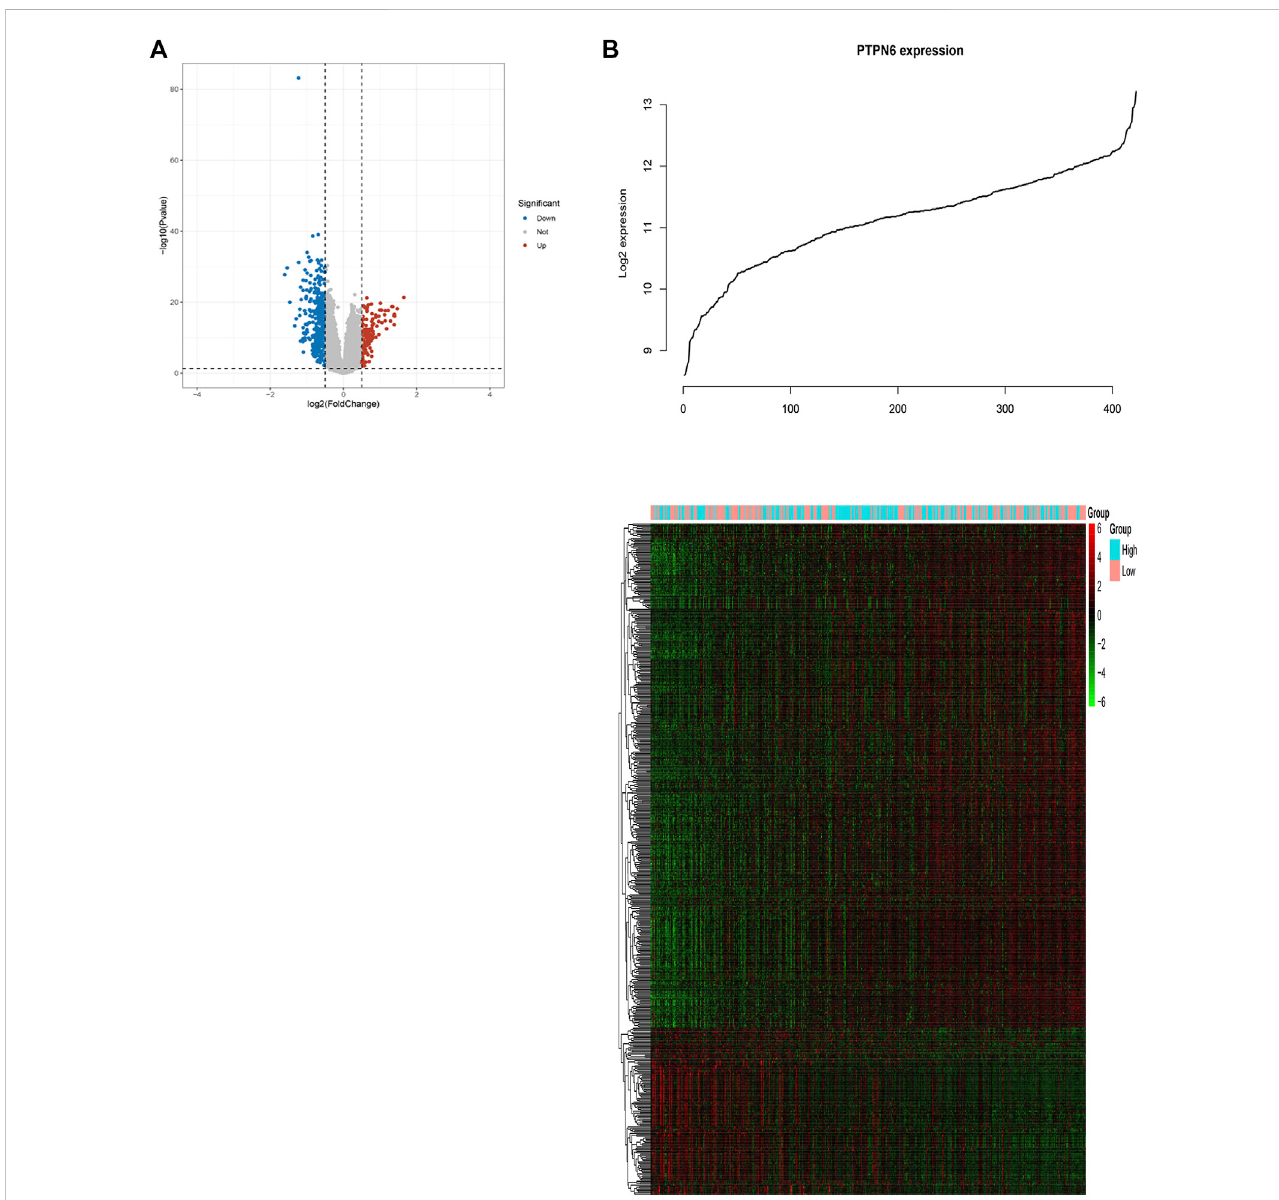
FIGURE 5 Genome-wide genes associated with PTPN6 expression. (A) Volcano plot of differential gene pro fi les between PTPN6 high and PTPN6 low. (B) Expression heatmap of PTPN6-associated genes. The top curve shows PTPN6 ’ s expression distribution of 156 CN-AML samples.